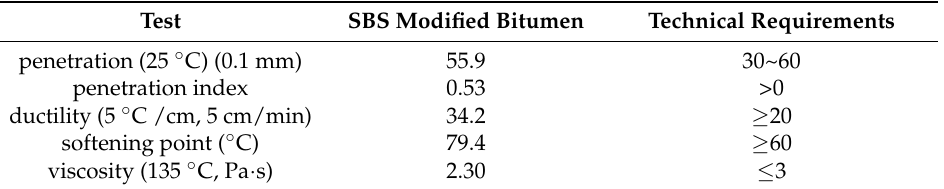
Table 1. Properties of SBS (Styrene Butadiene Styrene) modified bitumen.